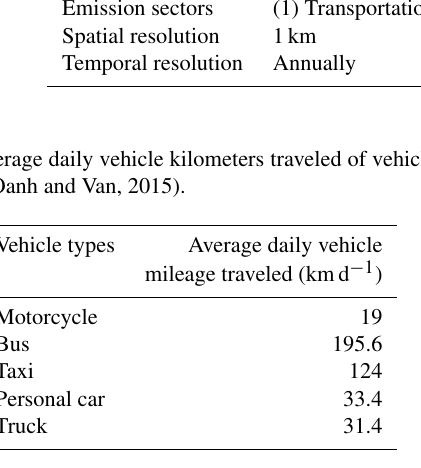
Table 4. Number of registered vehicles by type in HCMC over the years.